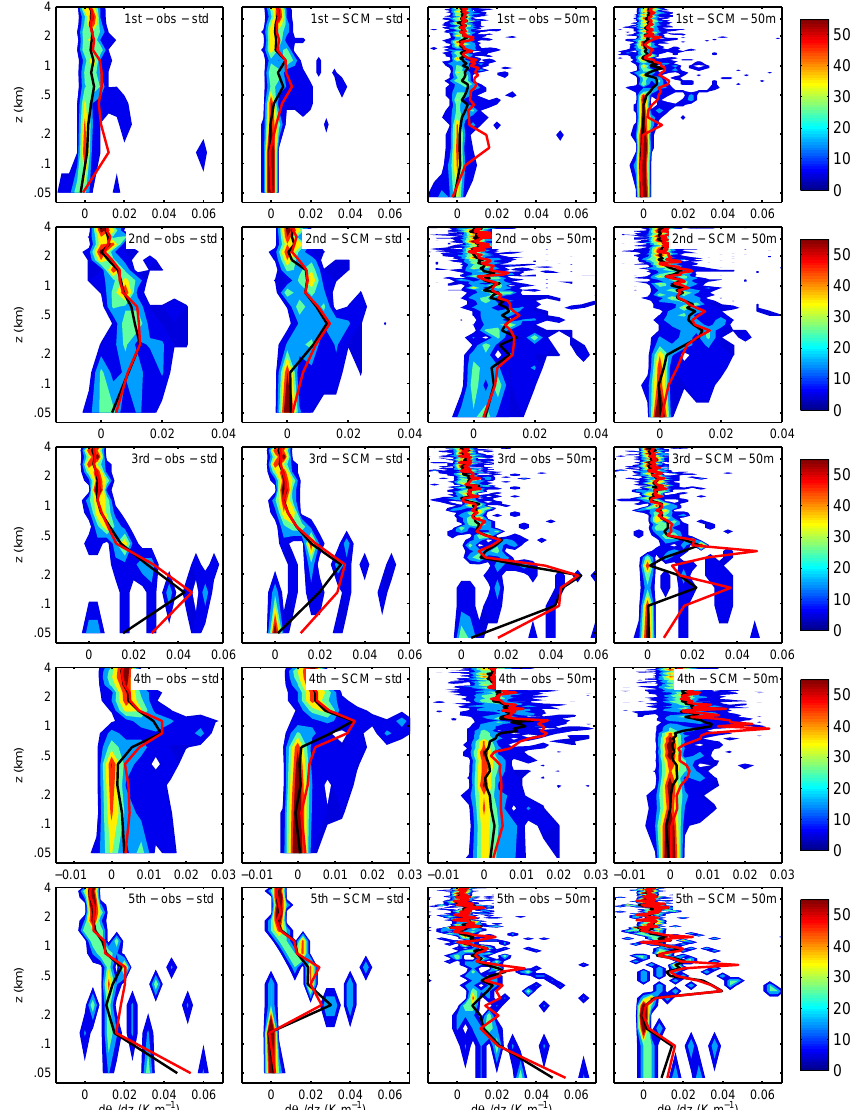
Fig. 5. Contours of the probability of static stability, given by the vertical derivative of equivalent potential temperature ( ∂θ e / ∂z ), as a function of height for the single-column model run initialised with observed surface temperature. The first and third columns show observations from the 6-hourly soundings for each regime, averaged onto the standard and 50m vertical resolutions of the SCM respectively. The second and fourth columns show SCM diagnostics at t + 6 h, run at standard and 50m vertical resolution respectively. The red and black lines are the mean and median static stability at each vertical level respectively. Note the logarithmic height scale and the change in scale on the x-axis.